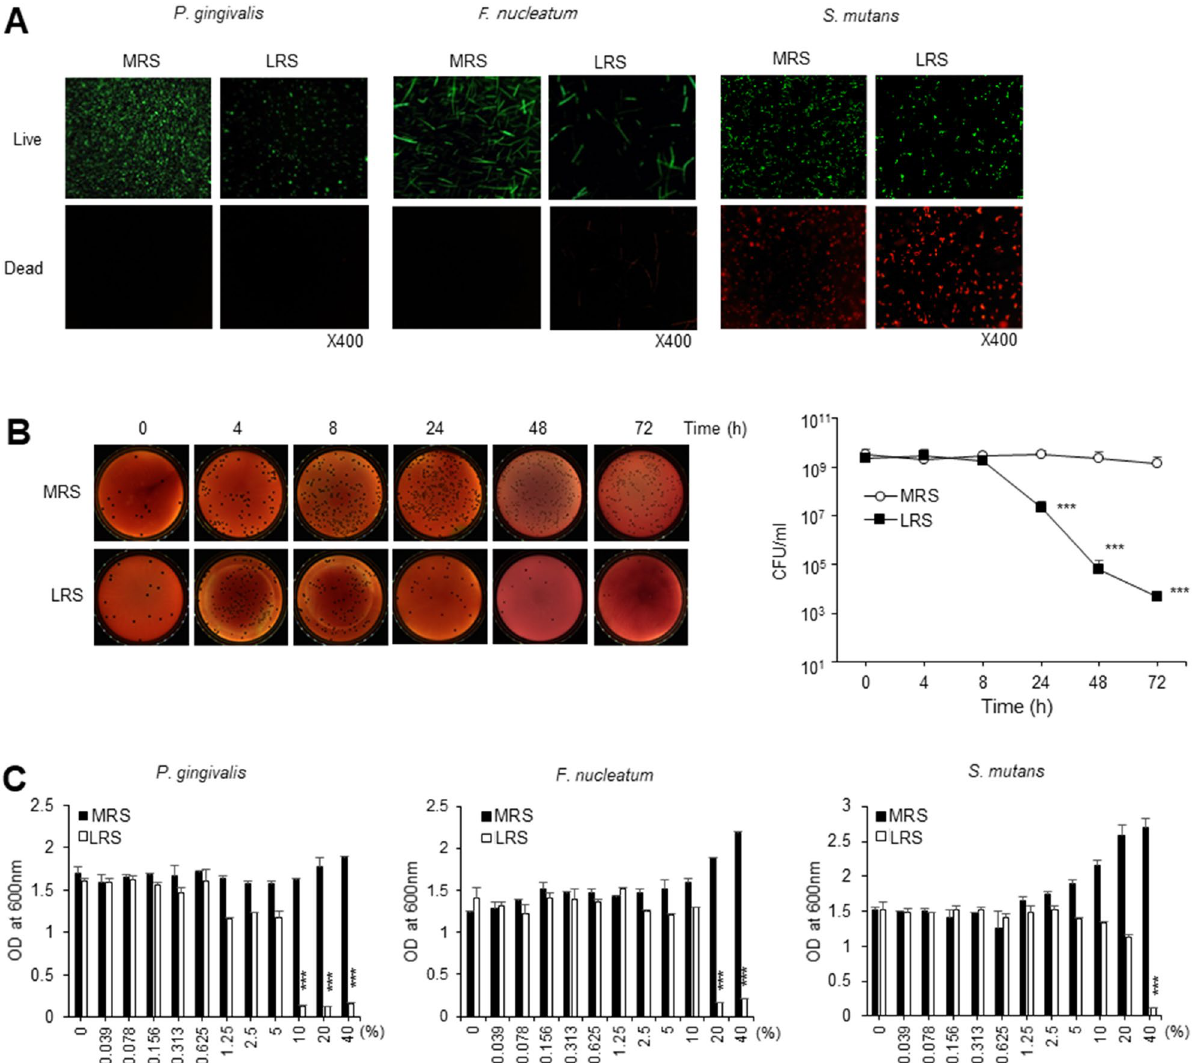
Figure 3. Analysis of the MIV of LRS and the effect of LRS on P. gingivalis, F. nucleatum, and S. mutans cell viability. ( A ) Representative fluorescence images of LIVE/DEAD BacLight viability assay of pathogenic bacteria exposed to 20% (v/v) LRS or MRS broth (control) for 24 h at 37 °C. Red fluorescence indicates dead or membrane-damaged bacterial cells and green fluorescence indicates live/healthy bacteria. Original magnification, ×400. ( B ) Quantification of P. gingivalis cell concentrations (CFU/mL) following treatment with 20% (v/v) MRS (control) or LRS. Black colonies developed after 6 days growth in a 37 °C anaerobic chamber. The time required to kill P. gingivalis treated with MRS or LRS is shown graphically. Significant differences from the control ( p < 0.001) are indicated by ***. ( C ) MIV of LRS for pathogenic bacteria, determined based on OD 600 values after 48 h incubation in an aerobic or aerobic chamber maintained at 37 °C. Significant differences from the control ( p < 0.001) are indicated by the genome (Fig. 5C). In addition, reuterin production was also measured in L. reuteri AN417 (Table 2), dem- onstrating that L. reuteri AN417 did not produce reuterin. This result was consistent with the genomic analysis results (Table 1).